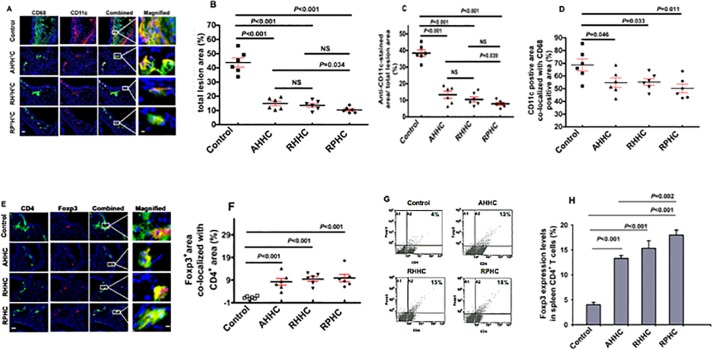
Assessment of inflammation-associated cells in the lesions of B6;129S-Ldlr
tm1Her
Apob
tm2Sgy
/J mice mice fed a high-fat diet after immunization with constructs AHHC, RHHC, and RPHC.(A) Photomicrographs showing IHC staining of CD68 (green) and CD11c (red) markers (scale bar: 100 μm and 12.5μm for magnified ones). (B) Scatter plot showing anti-CD68-stained area in lesion versus total lesion area; Data are given as the mean of 6 mice. (C) Scatter plot showing anti-CD11c-stained area in lesion versus total lesion area; Data are given as the mean of 6 mice. (D) Co-localization of CD68+ and CD11c+ areas (derived from Fig 3B and 3C). (E) Photomicrographs showing IHC staining of CD4+ T-cells (green) and Foxp3+ Treg cells (red) (scale bar: 100 μm and 12.5μm for magnified ones). (F) Scatter plot showing anti-Foxp3-stained area versus anti-CD4+ stained area in lesion (N = 6). (G) Representative analysis of Foxp3 expression by CD4+ T cells in lymph nodes from construct-immunized mice fed on a high-fat diet as assessed using flow cytometry. (H) Percentage of Foxp3+ cells among CD4+ spleen cells as analyzed by flow cytometry. Data are expressed as mean of 3 analyses ± SEM. Differences between groups are shown.